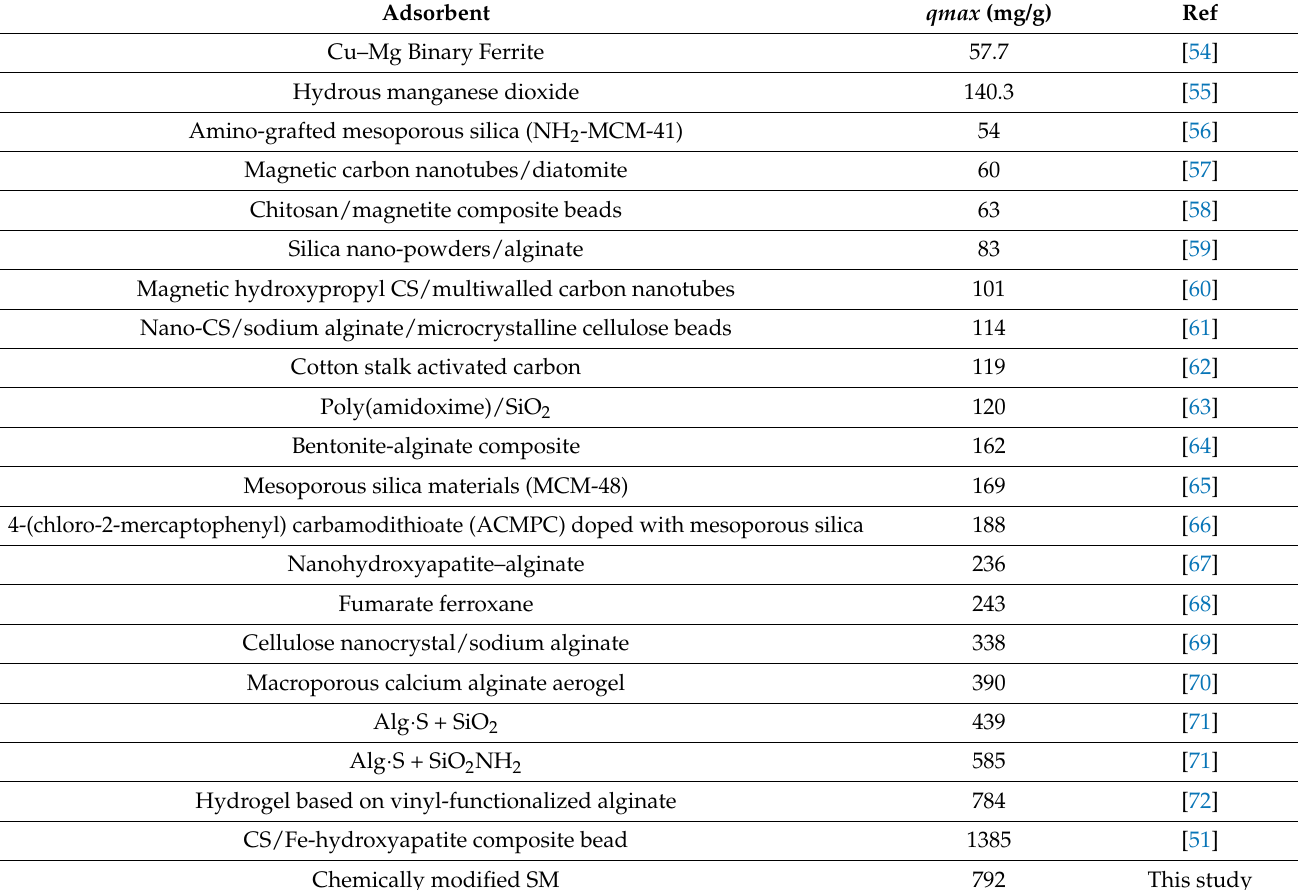
Table 4. Comparison of adsorption capacity of the various adsorbents for Pb(II) removal. Adsorbent qmax (mg/g) Cu–Mg Binary